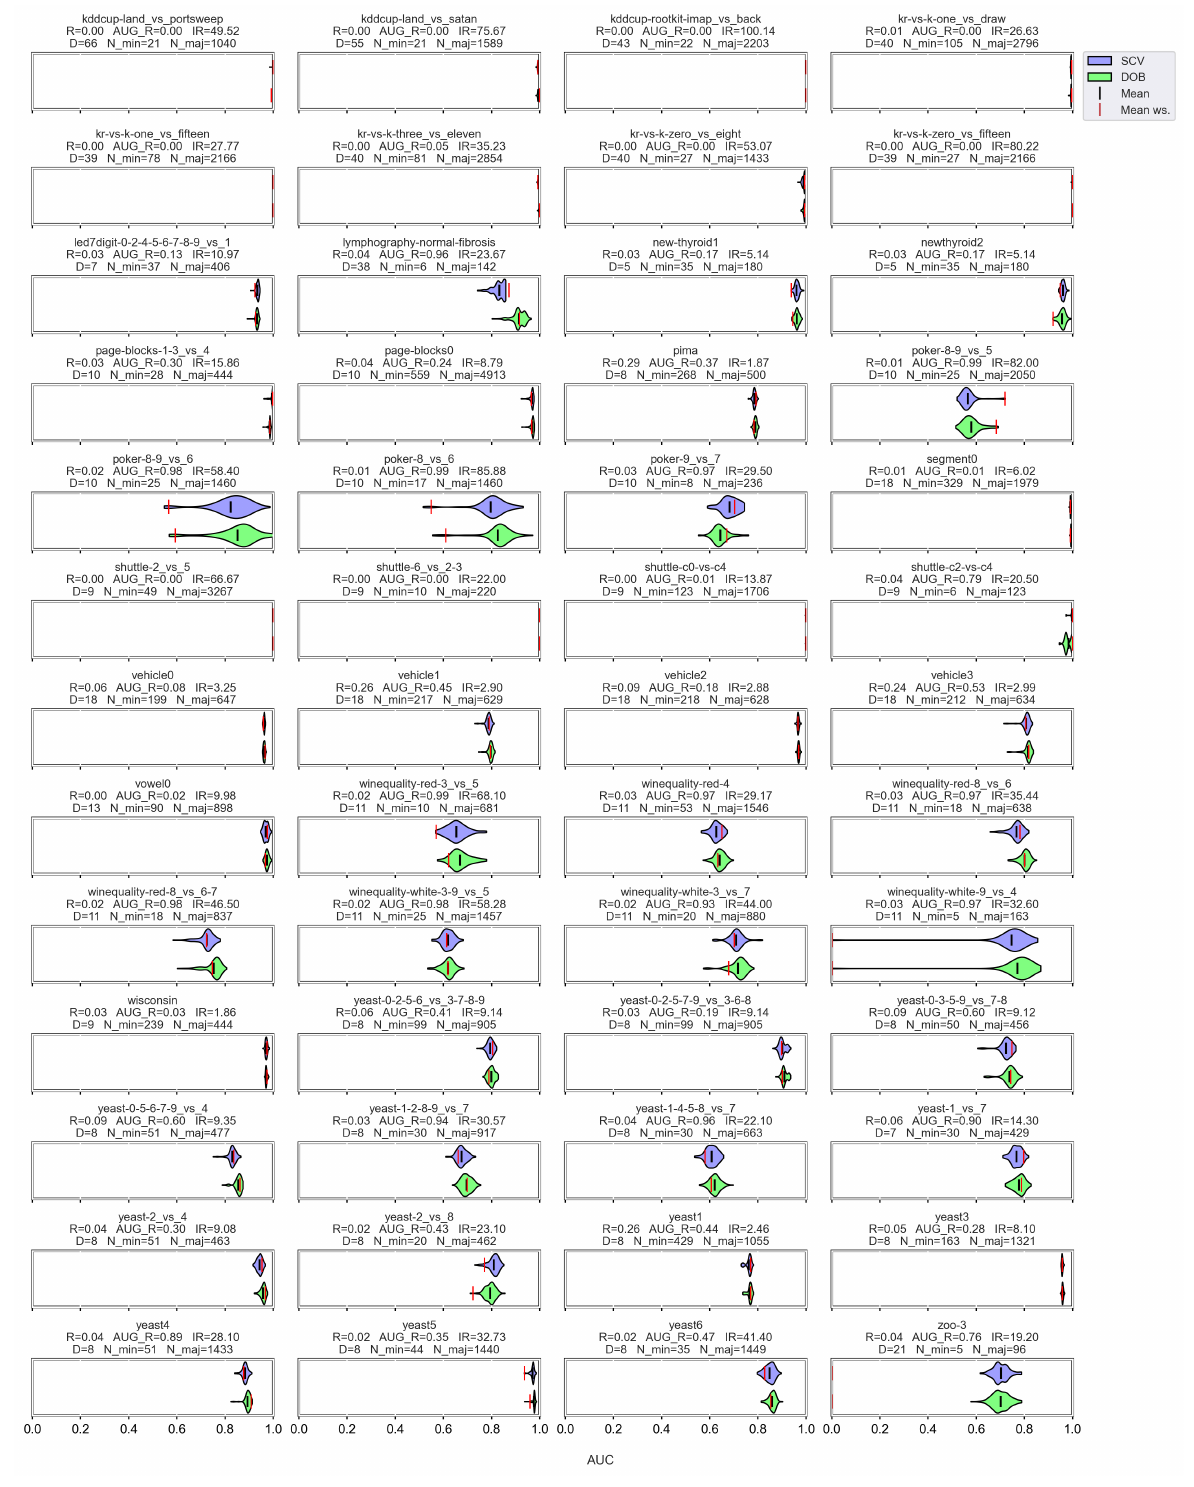
Figure A5. AUC values resulted by the DTree classifier and the named oversamplers per data set of